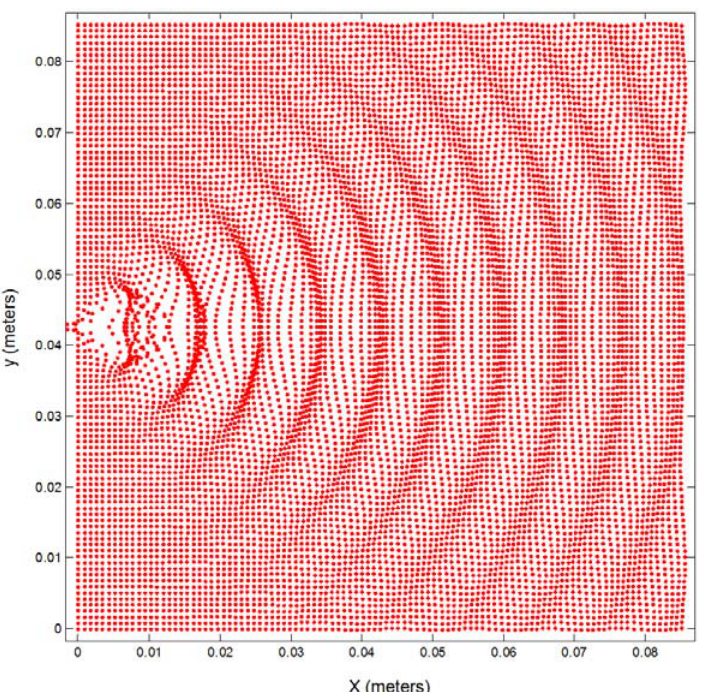
Figure 5. Point source emission at 40 kHz affected by the radiation